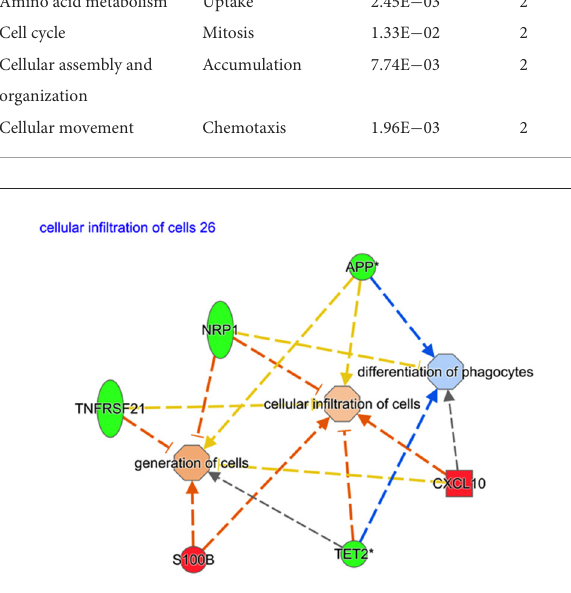
FIGURE1 Variation of gene ontological (GO) functions associated to a protective vaccine profile. The cartoons illustrate expression changes in genes or functions associated to Non-Infected in comparison to Infected sheep. Genes and the predicted downstream response are highlighted in color. Color intensity indicates the degree of increased (red) or decreased (green) relative expression of the individual gene expression and predicted activation (orange) or suppression (blue) of downstream function as a consequence of the measured gene expression. Expression of the selected genes (S100B, TET2, CXCL10, TNFRSF21, NRP1, and APP) are predicted to activate generation of cells and cellular infiltration but suppress differentiation of phagocytes in vaccinated sheep that show no sign of MAP infection. *Indicates that multiple identifiers in the dataset file mapped to a sing gene identifier within the Global Molecular